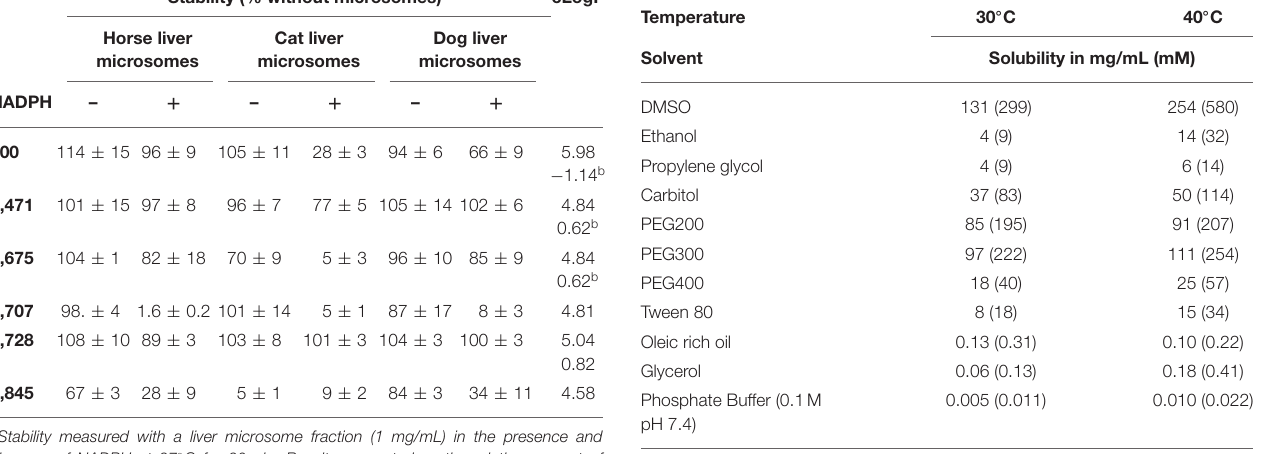
TABLE 6 | Formulation ease: solubility of 1,728 in various solvents classically used for formulation.